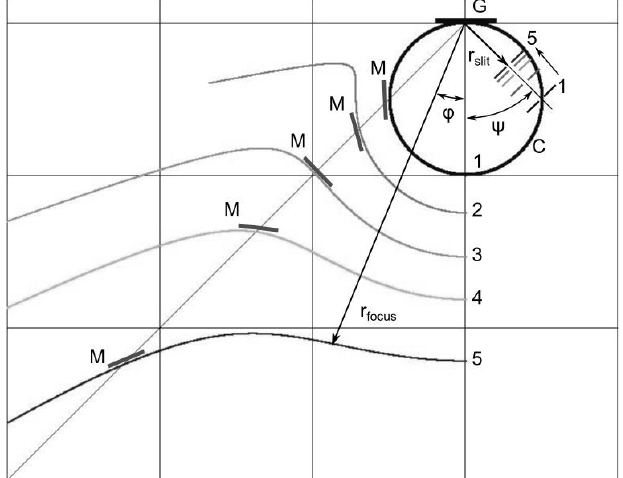
Fig. 1. G – diffraction grating, C – Rowland circle. The entrance slit positions 1 – 5 correspond to the focusing curves 1 – 5 according [1]. M – correspondent positions of the entrance surface of